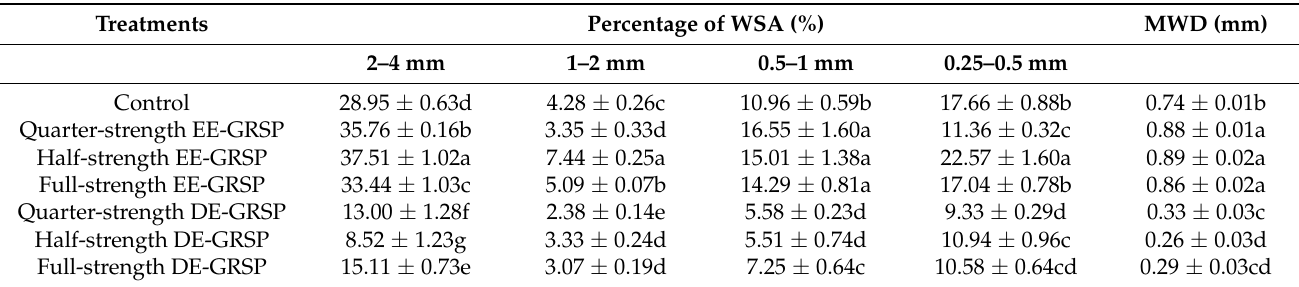
Table 2. Effects of exogenous GRSP on water-stable aggregate (WSA) content and the mean weight diameter (MWD) of trifoliate orange.